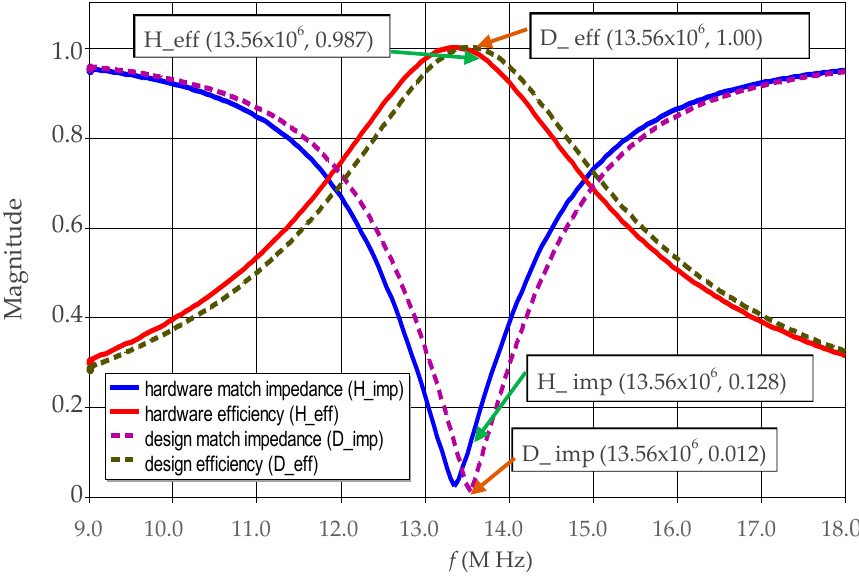
Figure 18. Efficiency and matching impedance for design and hardware.